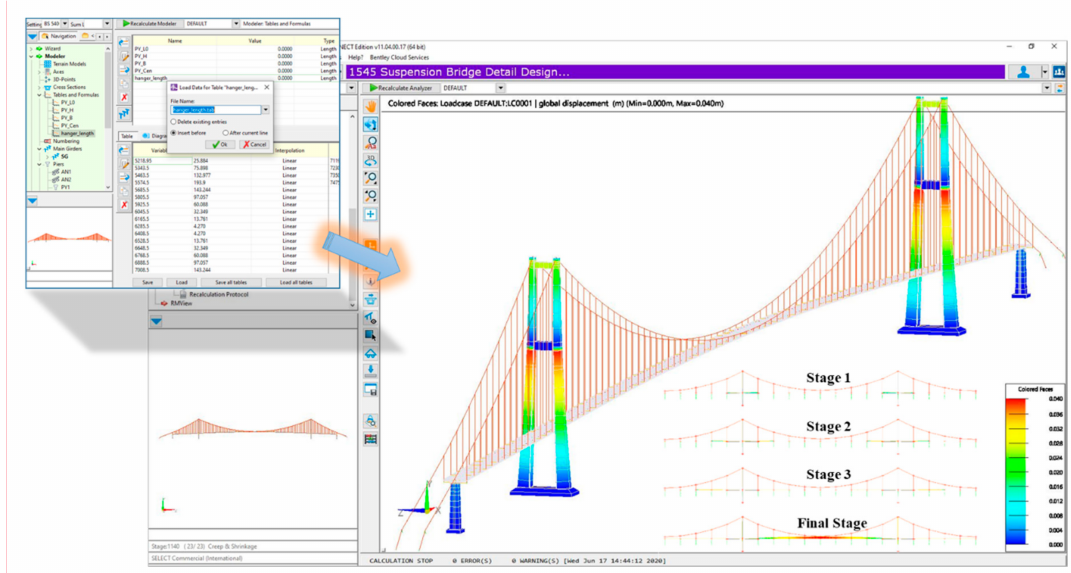
Figure 12. Global deformation of a suspension bridge in the RM Bridge (v11.04).